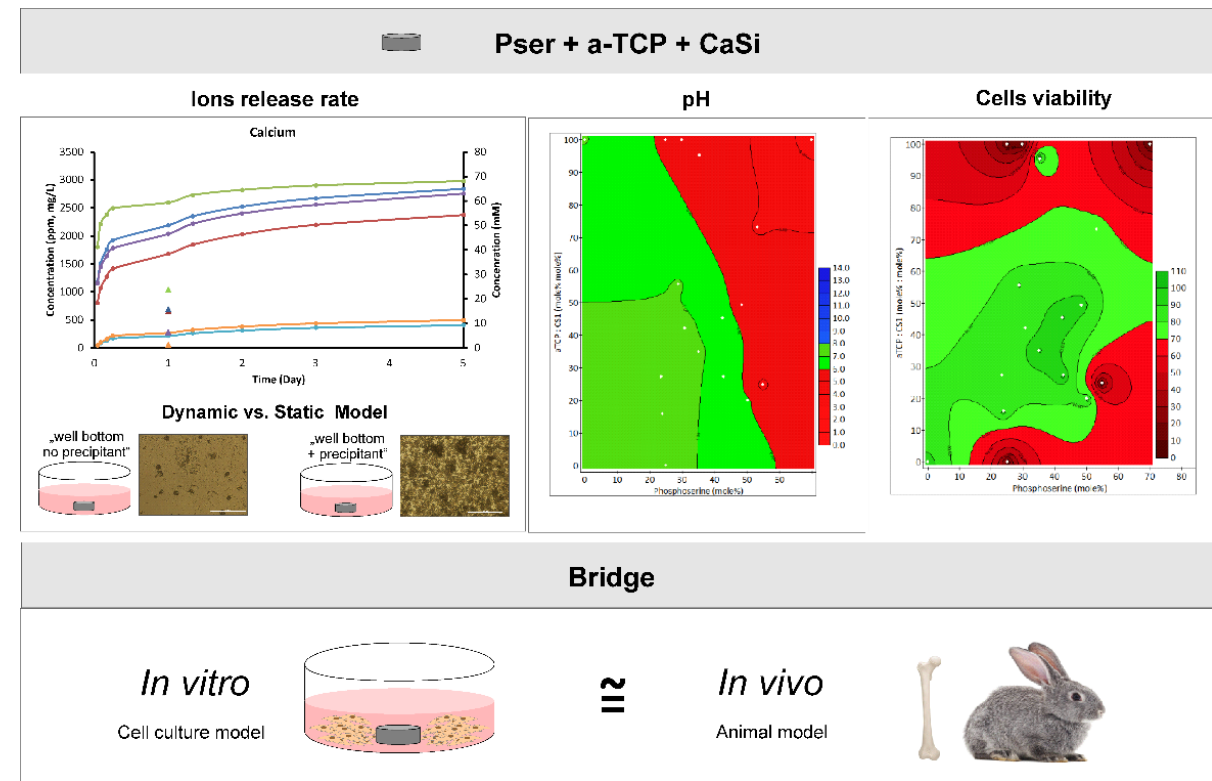
Figure 2. Scheme of the experimental design—simulation of conditions similar to in vivo .